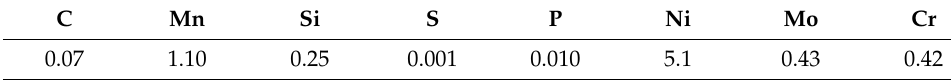
Table 1. The chemical composition of the 5% Ni steel (wt %).